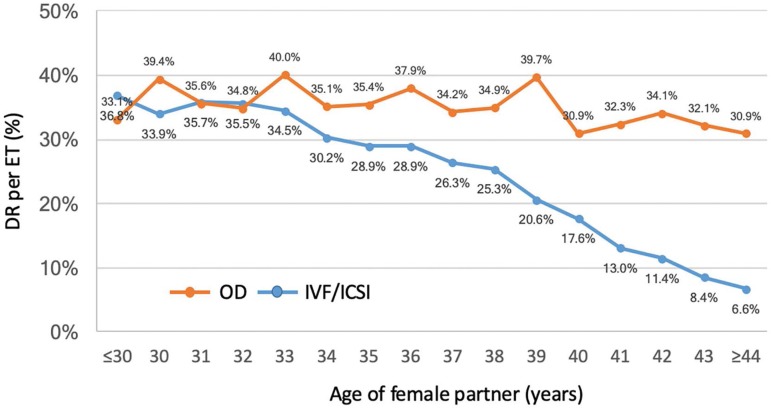
Delivery rate per embryo transfer according to woman´s age in
IVF/ICSI and OD cycles, RLA 2016